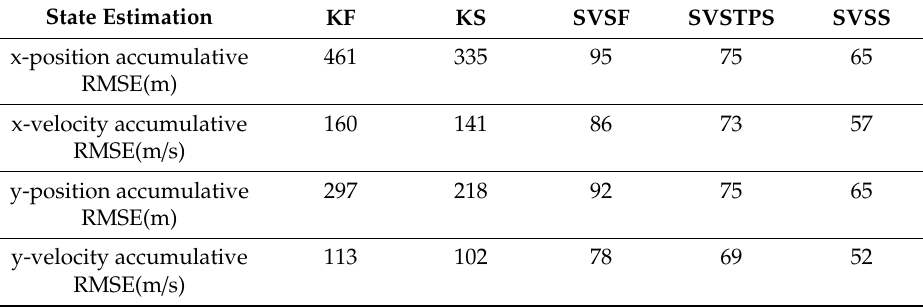
Table 3. The state estimation accumulative RMSE on x-axis and y-axis (m) for di ff erent